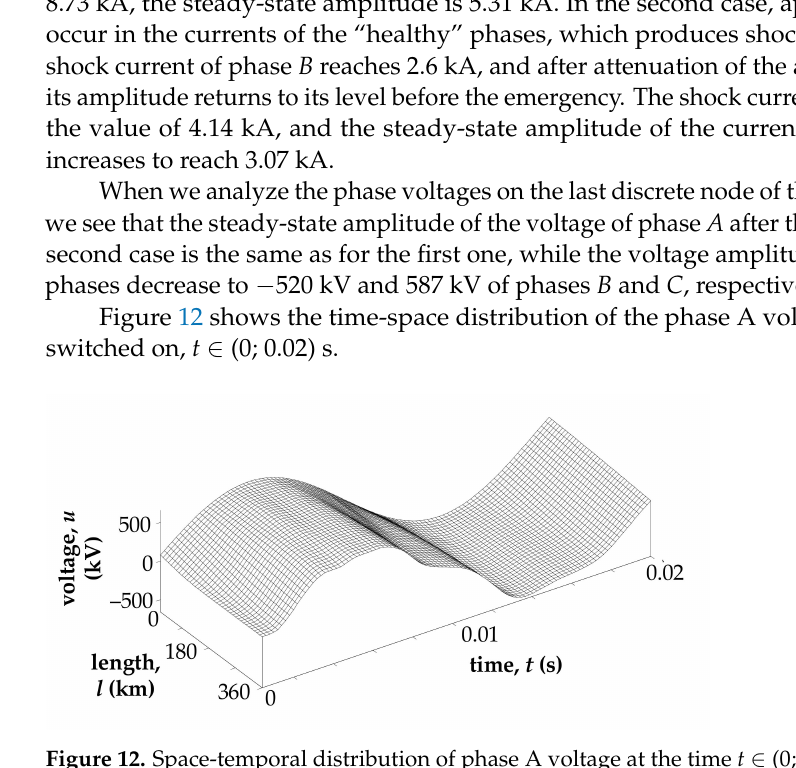
Figure 12. Space-temporal distribution of phase A voltage at the time t ∈ (0; 0.02) s. The voltage of phase A has maximum oscillations at the end of the line, while there are no voltage oscillations at the beginning of the line. Figures 13 and 14 show the space-time distributions of phase B voltage and current when the line is switched on, t ∈ (0; 0.02) s.